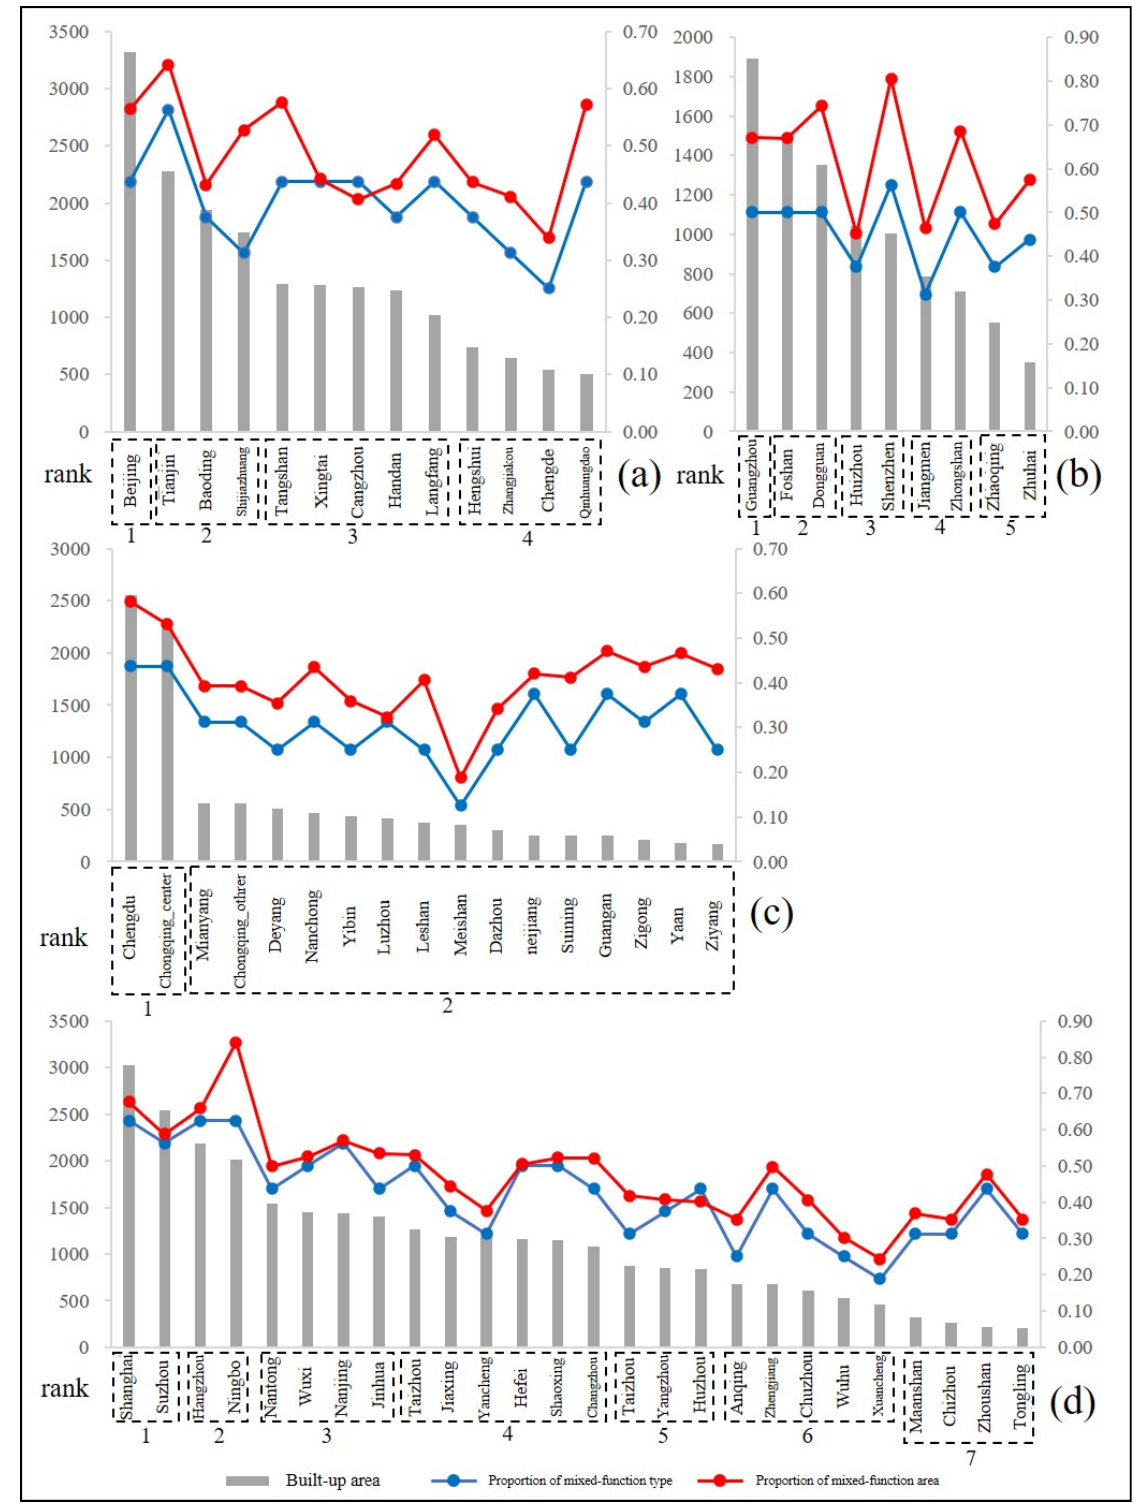
Figure 3. Statistical graph of urban functional area, ( a ): Beijing–Tianjin–Hebei, ( b ): The Yangtze River Delta, ( c ): Chengdu–Chongqing, ( d ): The Pearl River Delta.